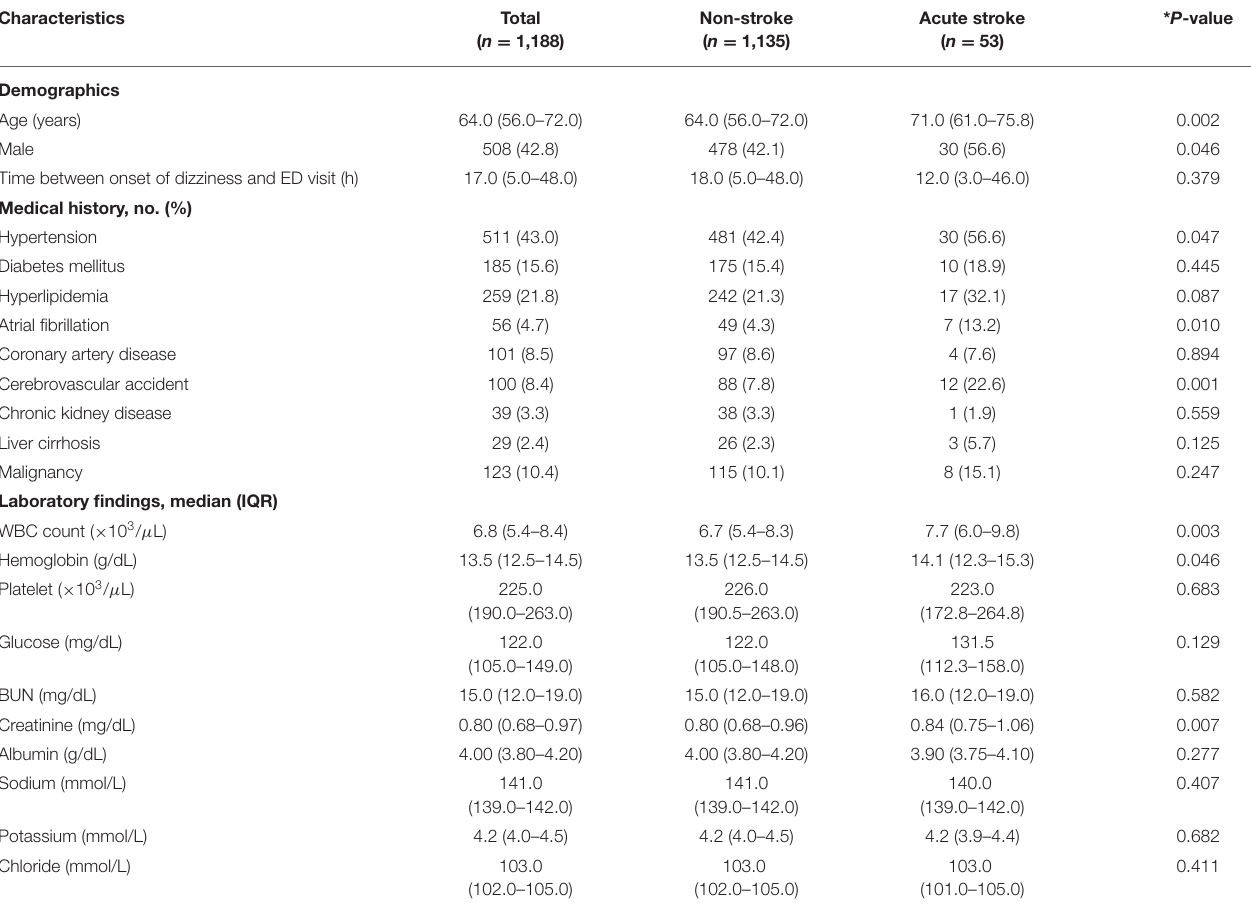
TABLE 1 | Baseline clinical characteristics and laboratory findings in the study population.